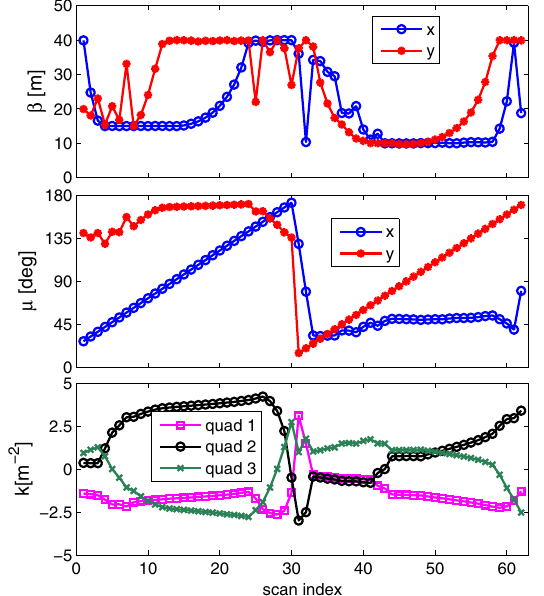
FIG. 2. β functions at the observation point, phase advances and quadrupole strengths as a function of the scan index. The first half of the scan is used to reconstruct the horizontal parameters, the second part provides the vertical 2D parameters, and the whole scan is used to obtain the coupling terms. exit of the magnetic bunch compressor. The layout consists of three quadrupoles with a length of 0.15 m separated by 1.0 m and 1.2 m and a profile monitor 10.7 m downstream of the last quadrupole.